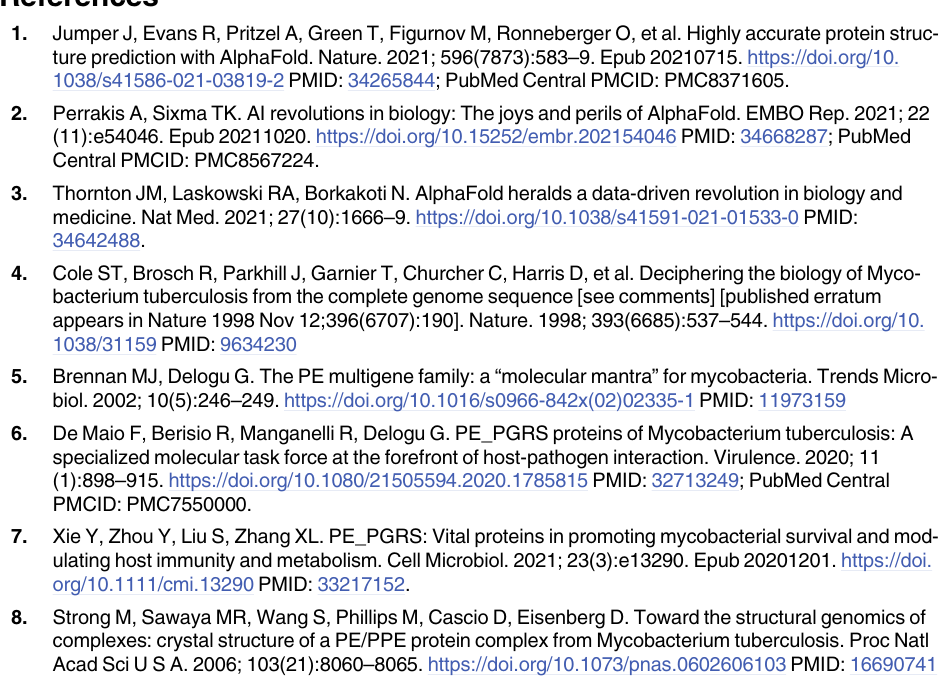
S1 Table. Predicted functions of PE_PGRS C-terminal domains based on structure align- ment. Z-score and root mean square deviations (RMSD) from most similar structures were computed using